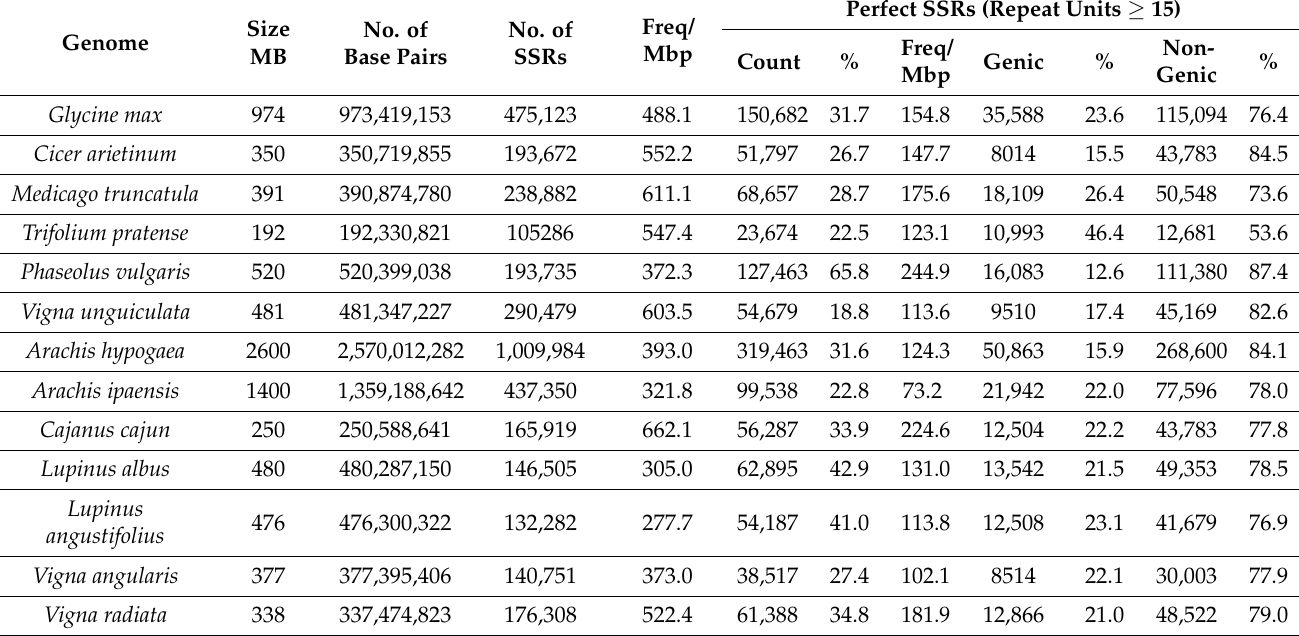
SSRs present in non-coding regions (Table 1). Table 1. Statistics of species-wise microsatellites based on genome size, number of base-pairs, number of SSRs per mega- base-pairs, genomic location, and the number of repeat